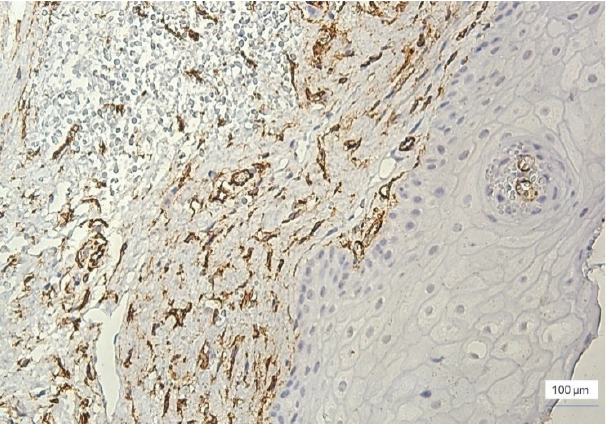
Figure 6. Moderate inflammation, GI = 2, and increased microvessel density at the stromal level, ×100: ( a ) stromal vascular polymorphism and intussusception, ×200, and ( b ) anti-CD34 immuno- histochemical staining and DAB chromogen.